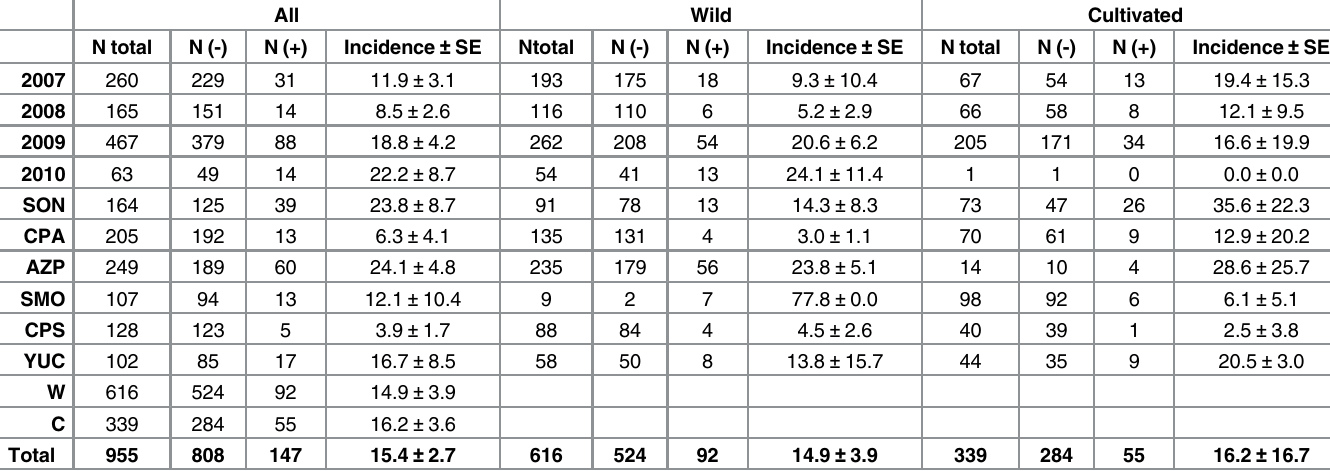
Potyvirus incidence in all, wild and cultivated populations. N total: total number of samples analysed; N(-): number of samples negative for potyvirus detection, N(+): number of samples positive for potyvirus detection; Incidence values and standard errors (SE) are indicated as percentage of plants positive for potyvirus detection.